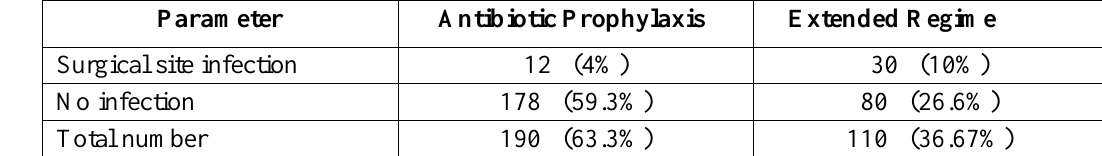
Table 4: Relation of SSI to the Antibiotic prophylactic or to Extended regime (N=300)